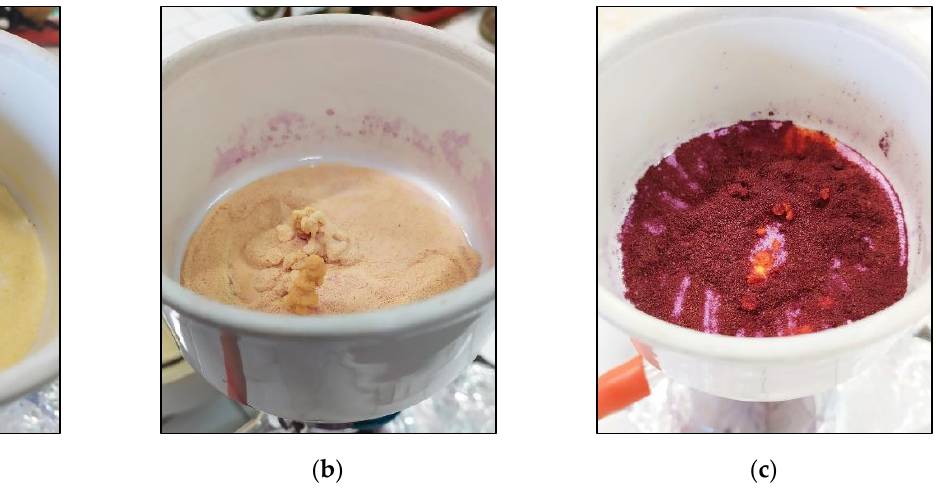
Figure 2. CR-CMC@ precipitated after synthesis using DMF ( a ), DCM ( b ) and toluene ( c ) as reaction Figure 2. CR-CMC@precipitatedaftersynthesisusingDMF( a ), DCM( b )andtoluene( c )asreactionsolvent. solvent. Table 2. Average precipitation yields for CR-CMC@ synthesized in different reaction